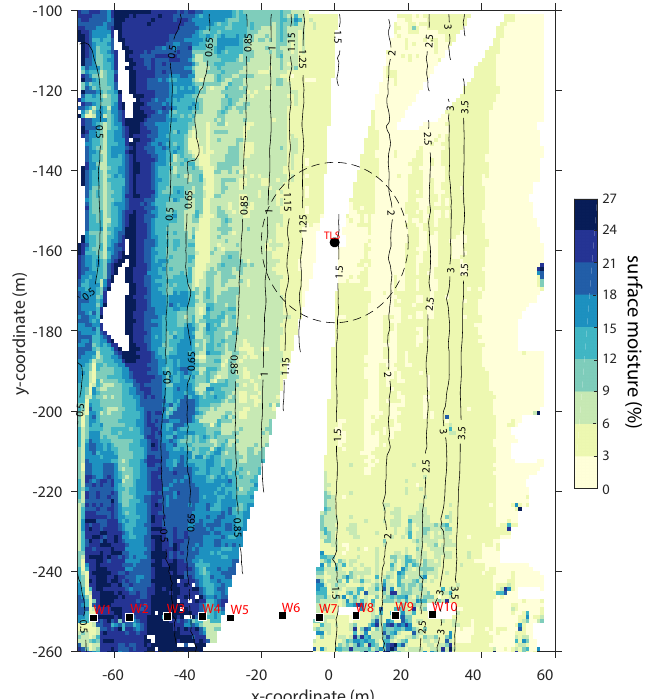
Figure 3. Example of a surface moisture map made with the Terrestrial Laser Scanner (TLS) on 29 September 2015 with a grid size of 1 × 1 m. The darker blue colors represent high surface moisture content with a maximum of 25% and lighter yellow colors represent low surface moisture content with a minimum of 3%. Positive x is landward, and positive y is to the north. W1–W10 indicate the position of the groundwater wells in a cross-shore array and the circle around the TLS indicates values that are less reliable according to Smit et al. [18]. The contours are elevation with respect to Mean Sea